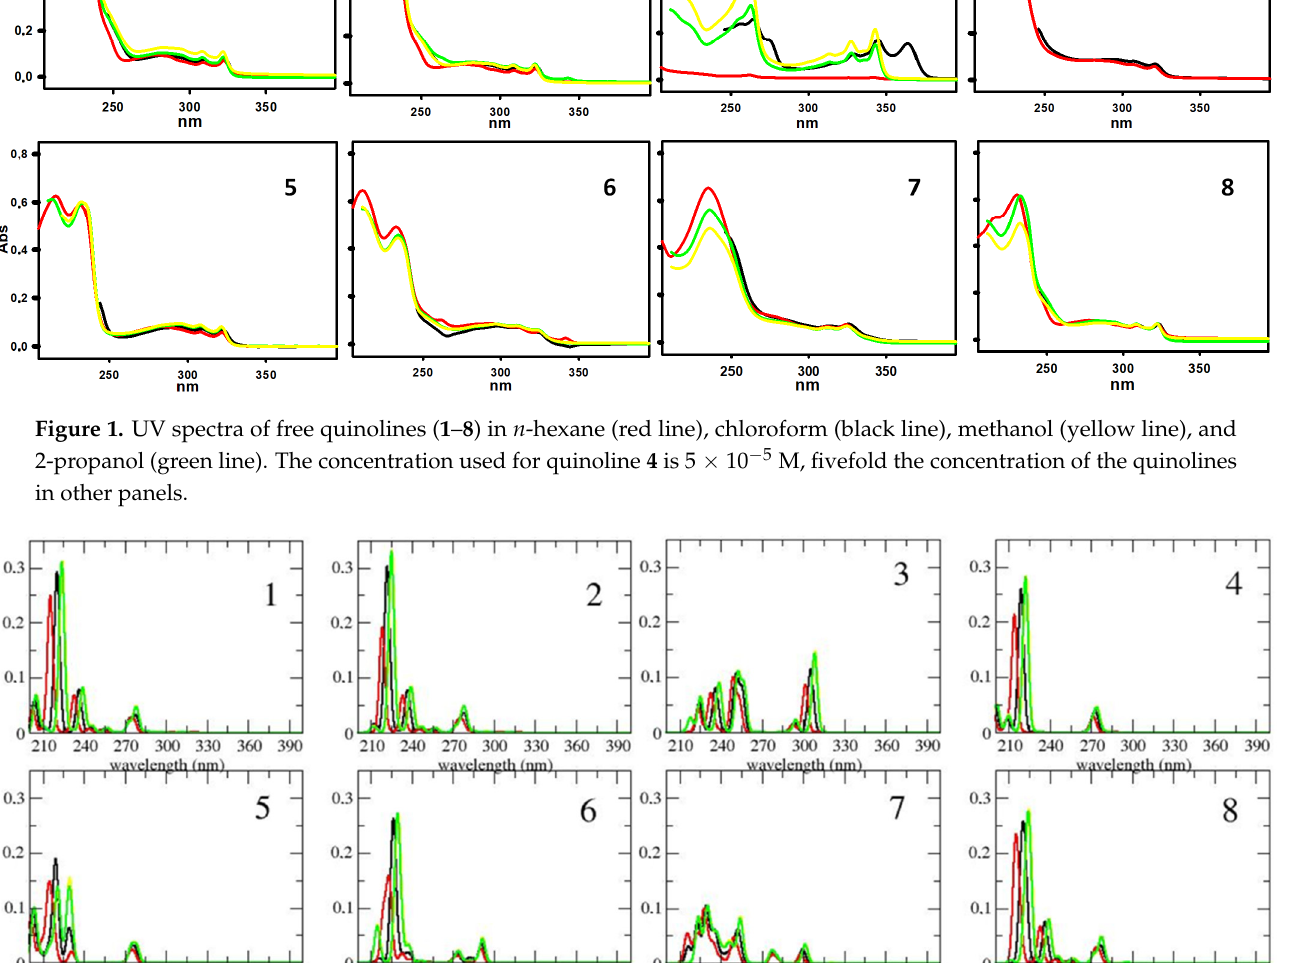
Figure 1. UV spectra of free quinolines ( 1 – 8 ) in n -hexane (red line), chloroform (black line), methanol (yellow line), and 2- propanol (green line). The concentration used for quinoline 4 is 5 × 10 − 5 M, fivefold the concentration of the quinolines in other panels.